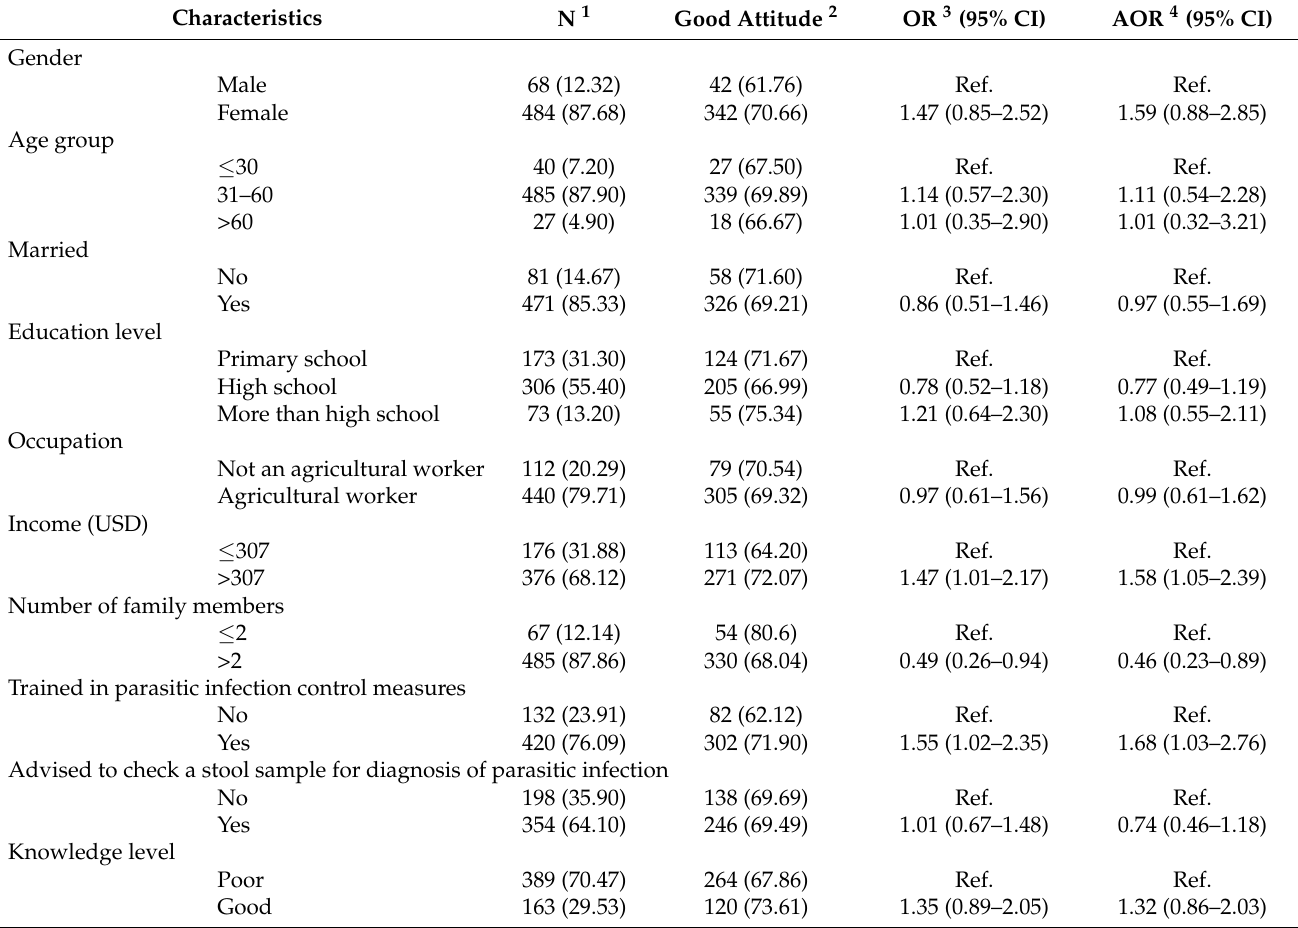
Table 5. Univariate and multivariate mixed-effect logistic regression analysis of factors influencing at-